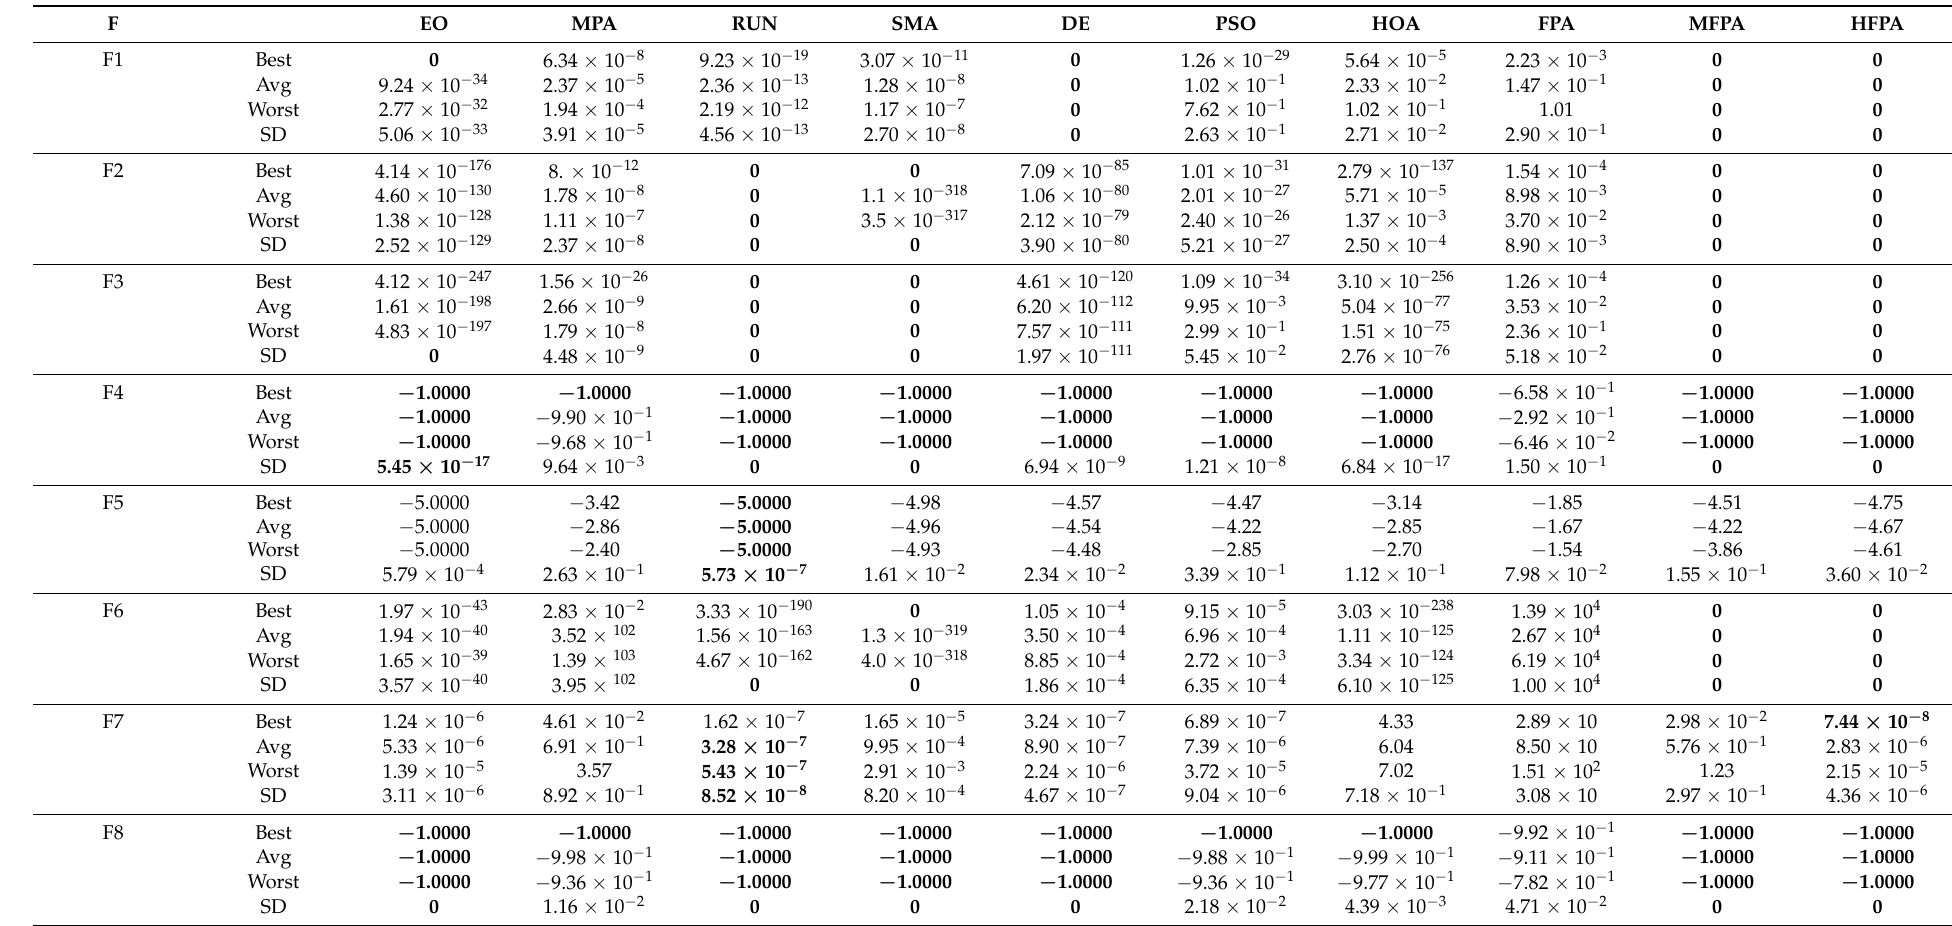
Table 3. Comparison under the unimodal mathematical test